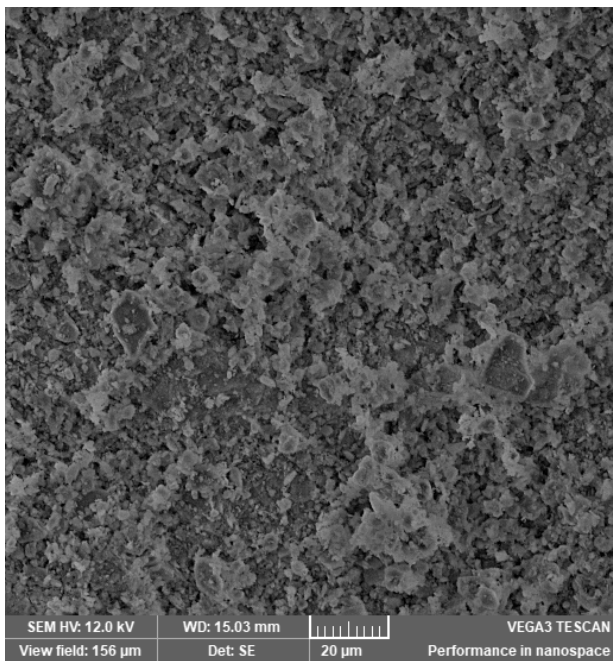
Figure 3. The SEM analysis of the zeolite sample Cal 1.